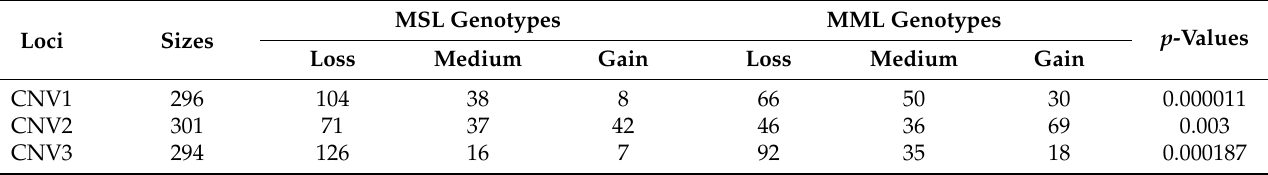
Table 4. Statistical Association Analysis of Three CNVs of DNAH1 with Litter Sizes in